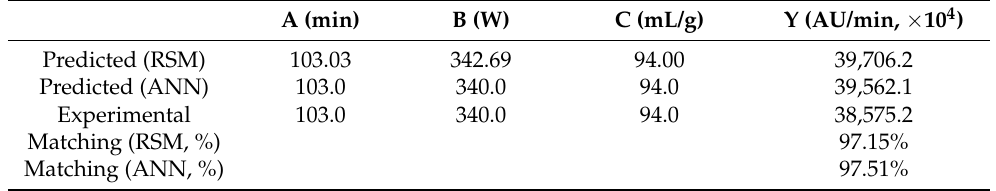
Table 5. Predicted and experimental values of the response obtained under optimal conditions ( n =